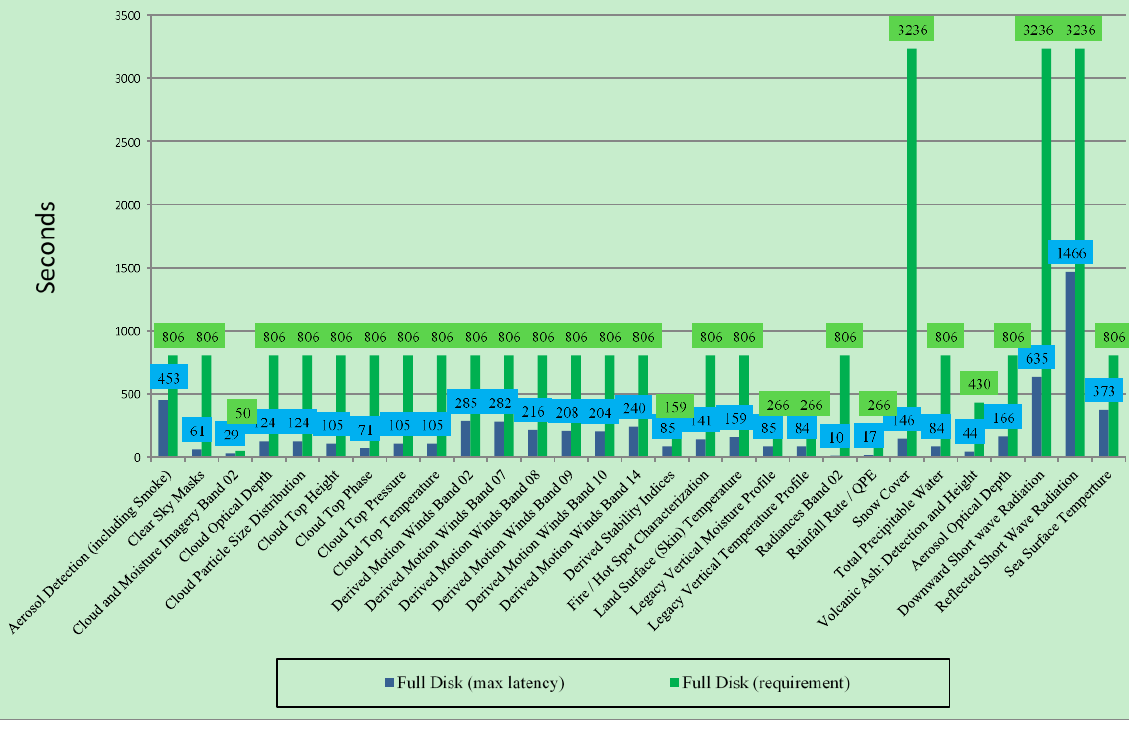
Figure 6. Product latency measured for a full disk ABI scene. Full disk imagery is collected every 5 min. Green bars indicate required values and blue bars measured values. Latencies for CMI Band 2 are shown because it has the highest spatial resolution at 0.5 km pixels and represents the stressing